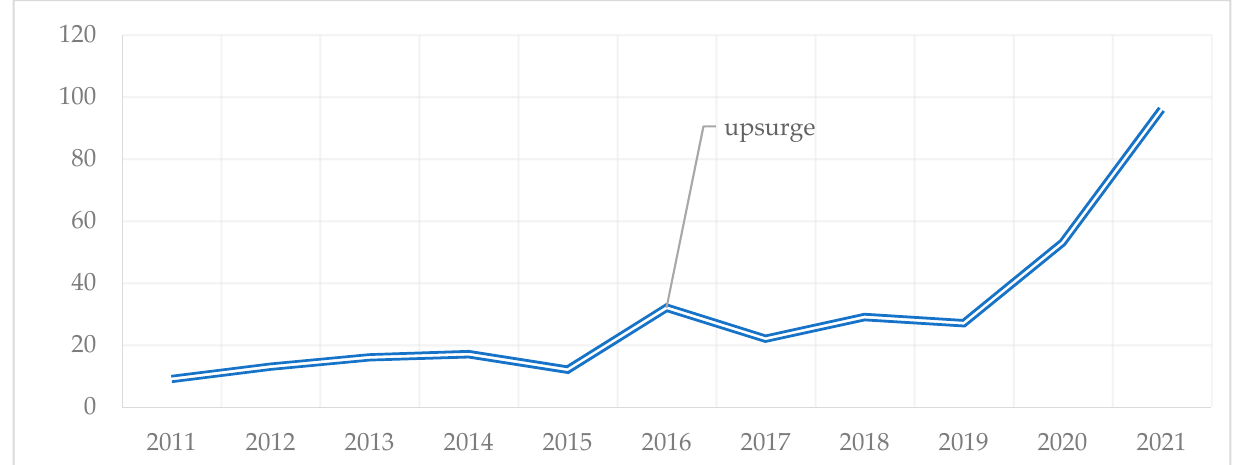
Figure 2. Upsurge in publications from 2016 .